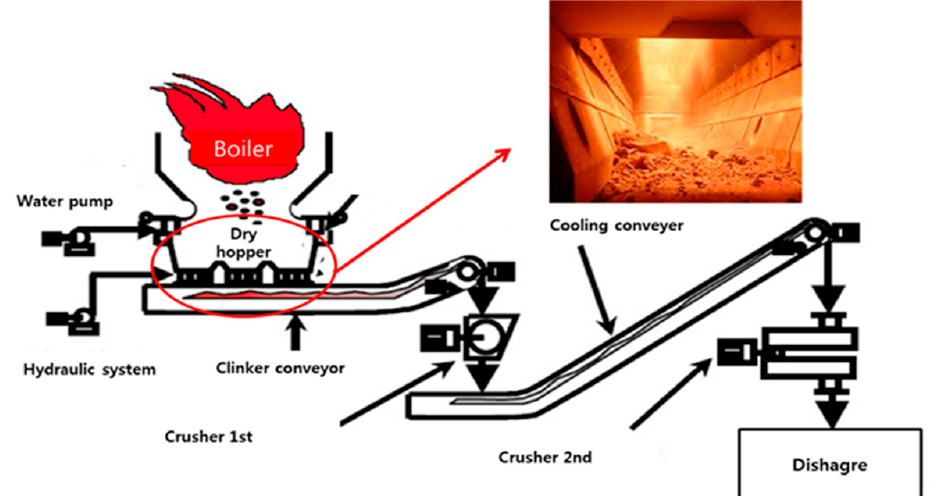
Figure 1. Bottom ash discharging system by the air-cooling process.